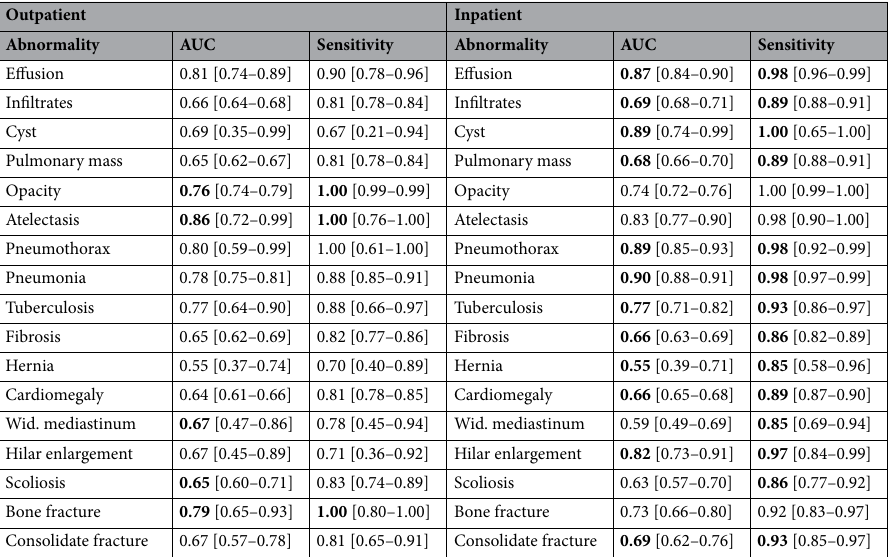
higher sensitivity will result in fewer sick patients being labeled as healthy. Simultaneously, more healthy patients were labeled as sick potentially increasing the radiologists’ workload. Favoring sensitivity seems a reasonable decision as the framework was deployed for both inpatient and outpatient clinical centers. When deploying the framework at different centers, the decision boundary threshold can be adjusted depending on the expected proportion of sick and healthy patients. Due to the experiment execution protocol and testing data restriction,